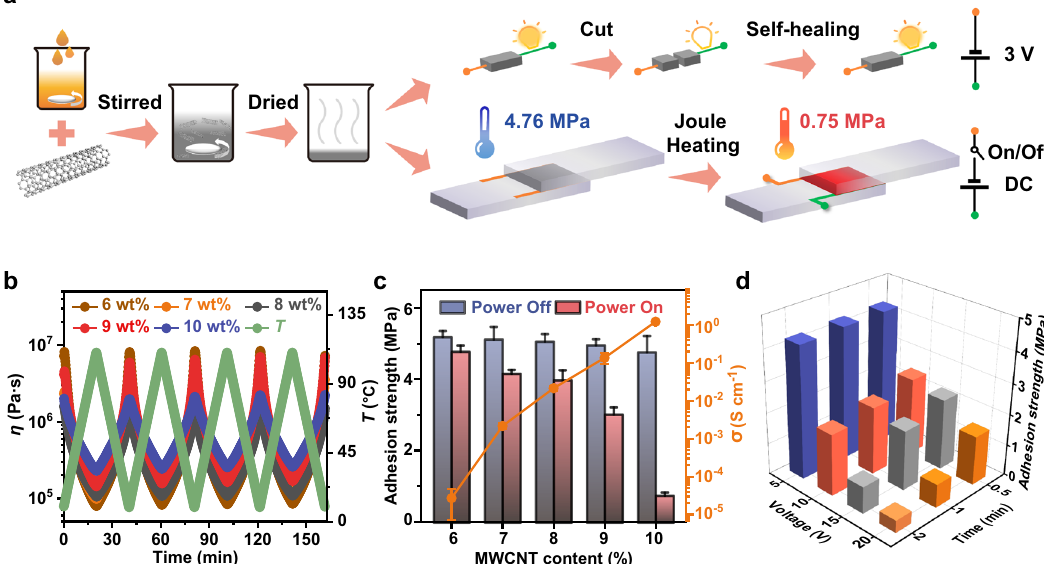
Fig. 3 | Application of Tri-HT adhesive materials. a Schematic of preparation of multifunctional Tri-HT/MWCNTs. During joule heating, copper foil tapes were attached to the edge of the substrates for electrical connection. The direction of current is distinguished by different colors. b Temperature-dependent viscosity of Tri-HT/MWCNTs. c Adhesion strengths and electronic conductivity of Tri-HT/